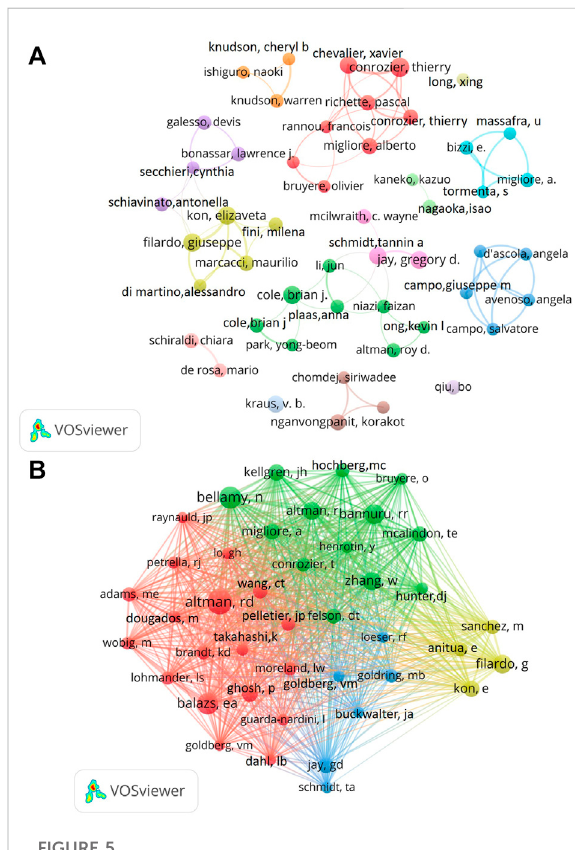
FIGURE 5 Visualizationmapofauthorsandco-citedauthorsdevotedto HA for the treatment of OA research. (A) Cooperation network of authors. (B) Co-citation network of